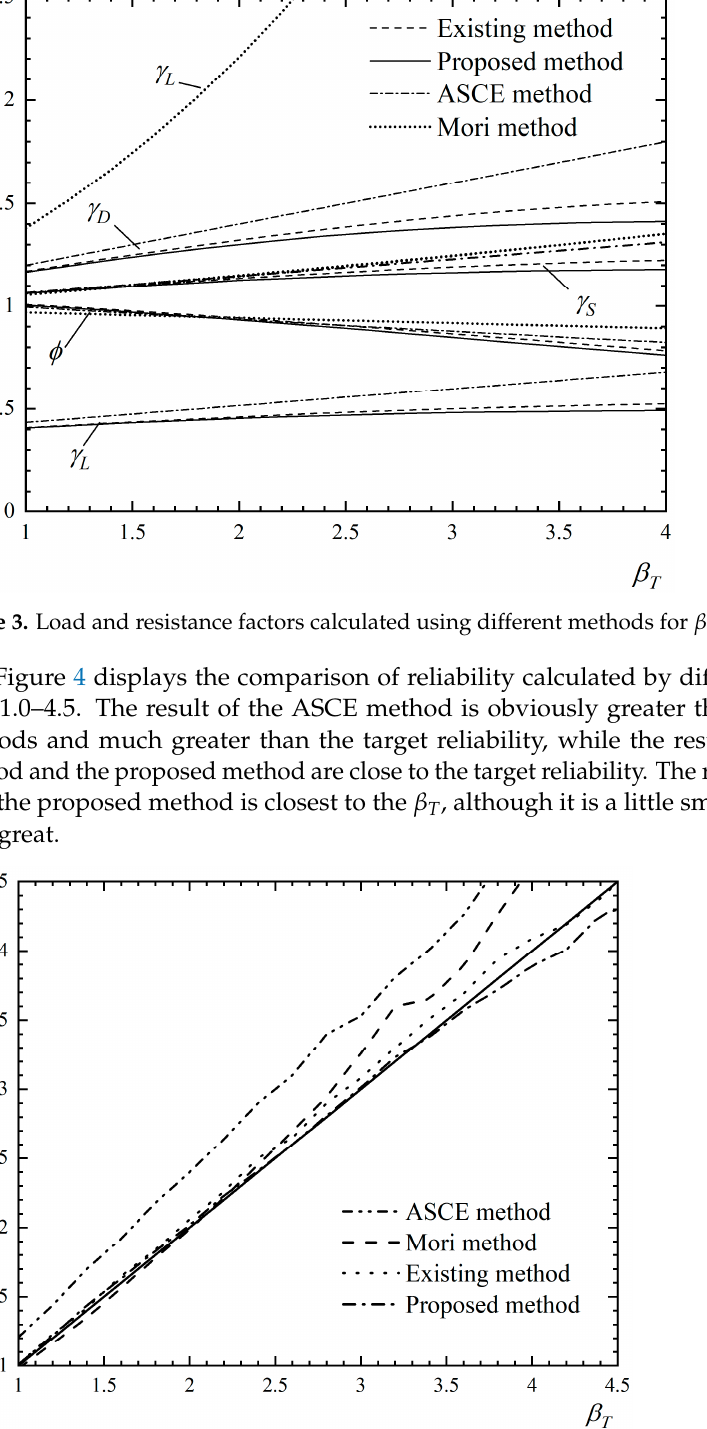
Figure 4. Reliability calculated with different methods for β T = 1.0–4.5.